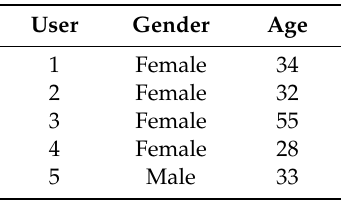
Table 1. Characteristics of the users.